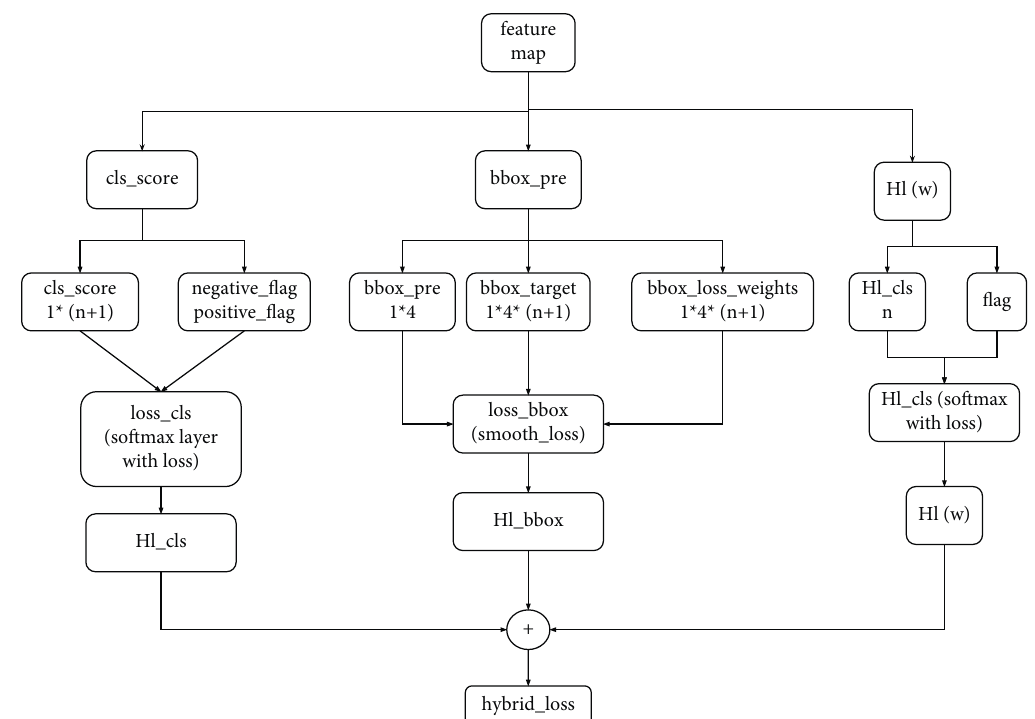
Figure 9: Step-by-step calculation of hybrid loss